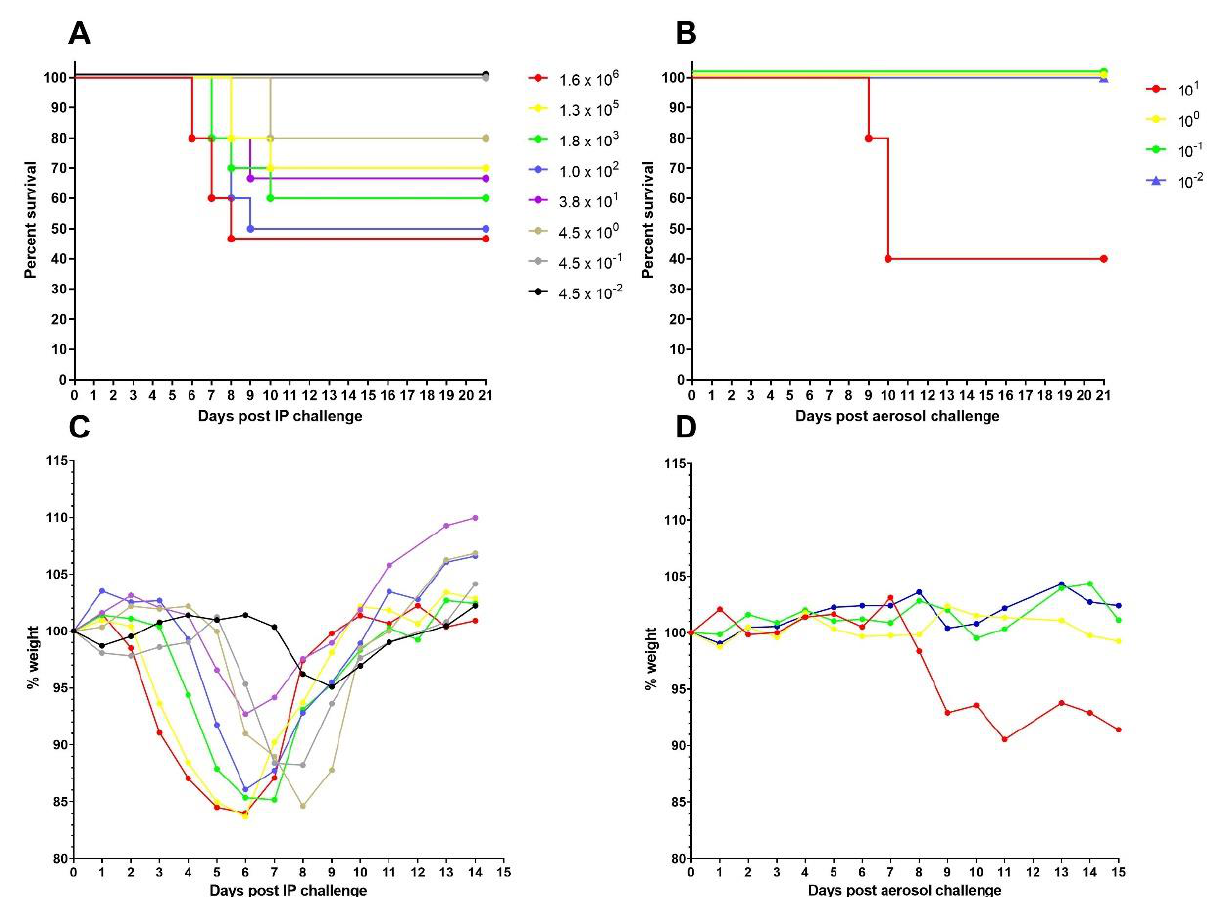
Figure 2. Survival and weight loss in A129 Interferon alpha/beta receptor deficient mice challenged with EBOV-Kikwit. Groups of mice were challenged with a range of doses of EBOV-Kikwit (shown by different colors) by the IP ( A , C ) or aerosol ( B , D ) route. Survival ( A , B ) and mean group weight ( C , D ) are shown. For weight loss, the mean group weight on the day of challenge was taken as 100%. For aerosol challenge, the results are from a single experiment with groups of 5 mice per dose. For IP challenge, the results are combined from two studies using the same stock of EBOV-Kikwit with groups of 5 in the first study and 10 in the second study resulting in an n = 15 for 10 6 (red) and 10 2 (purple) used in both experiments.